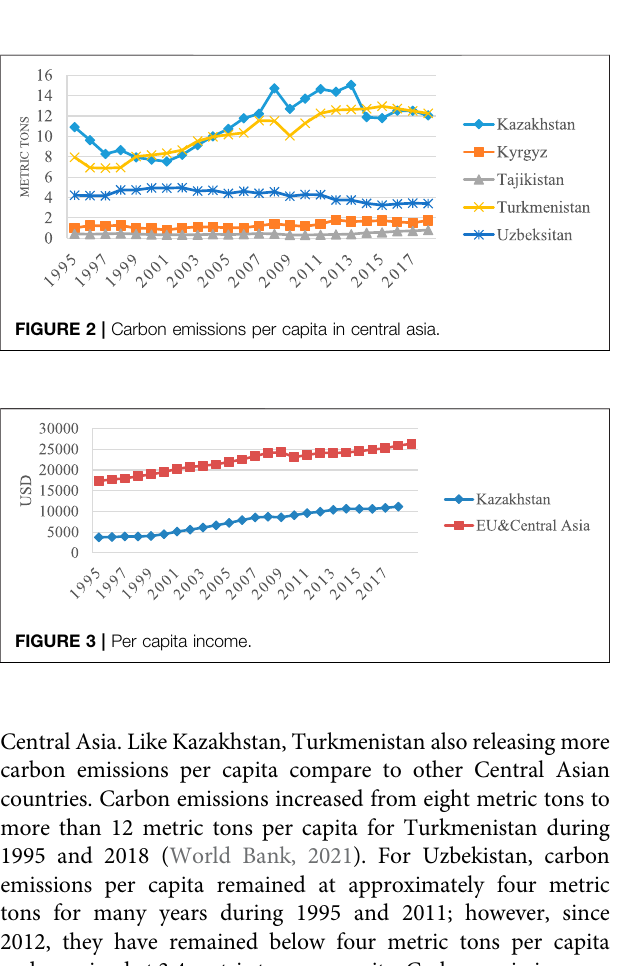
FIGURE 1 | Carbon emissions per capita.